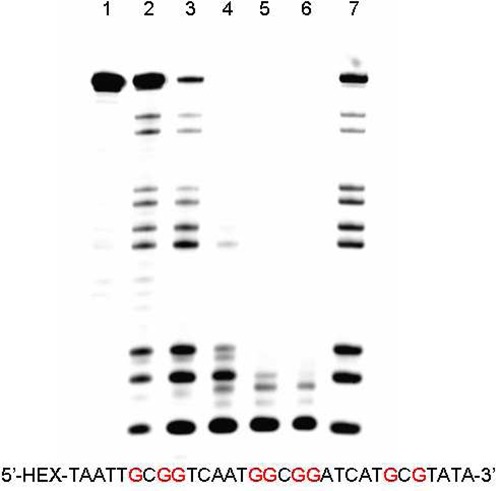
Polyacrylamide gel electrophoresis analysis of ODN 1. Treat the ODN 1 (20 pmol) with piperidine at 90°C for 30 min, after oxidized by different concentration of K2WO4 and H2O2. The reacting concentration of K2WO4 in lanes 1–6 was 0, 5, 10, 15, 20 and 25 mM, respectively. The reacting concentration of H2O2 in lane 1–6 was 0, 50, 100, 150, 200 and 250 mM, respectively. Lane 7: G-ladder (DMS treated).